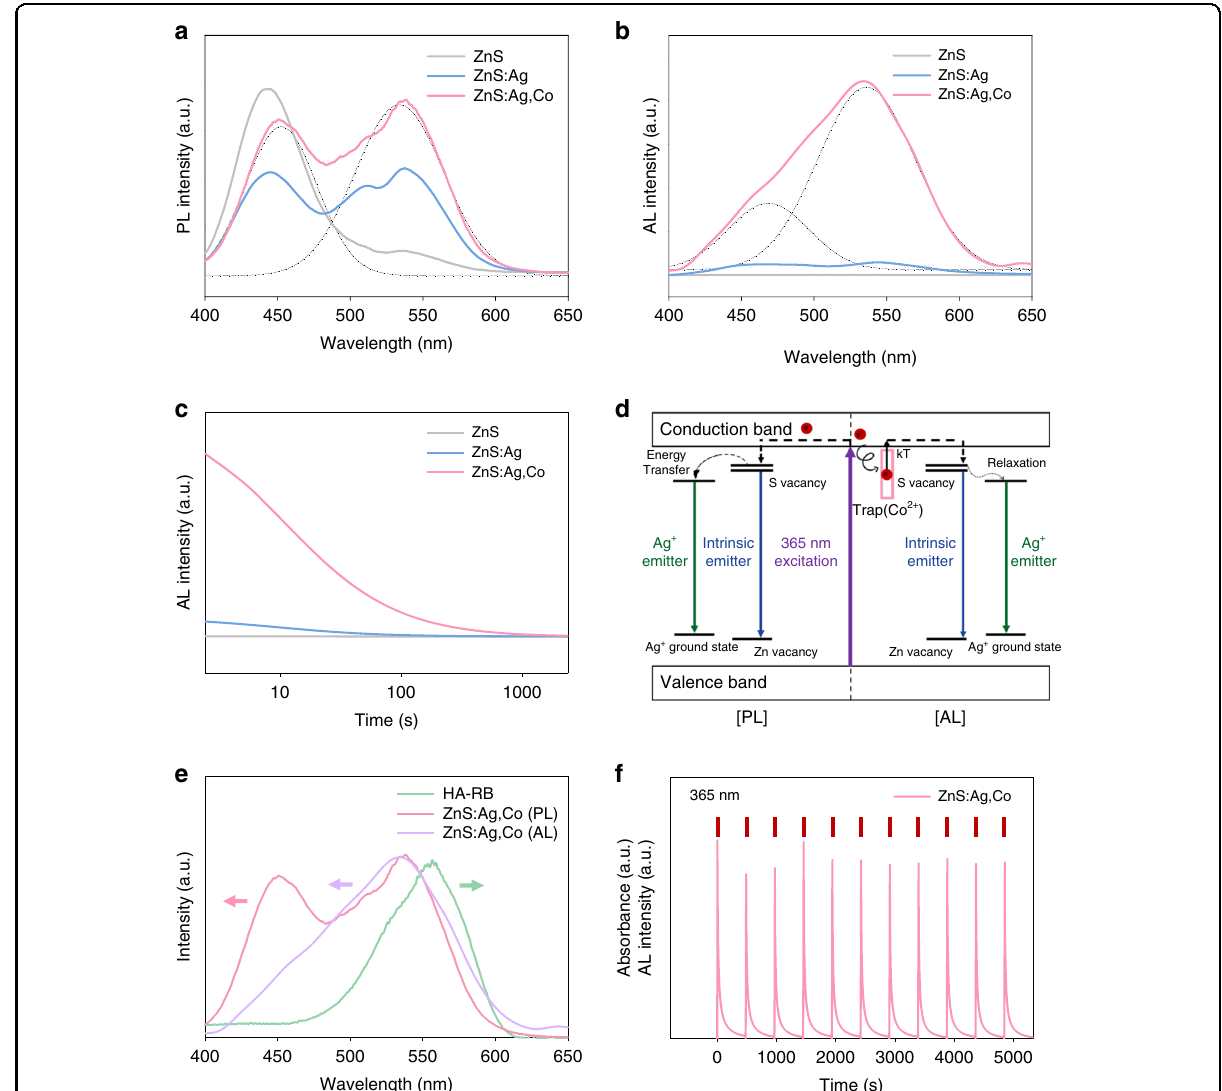
Fig. 3 The luminescence characteristics of ZnS:Ag,Co particles. a PL spectrum, b AL spectrum, and c afterglow decay curves of ZnS, ZnS:Ag, and ZnS:Ag,Co particles after UV light irradiation, respectively. d The luminescence mechanism of ZnS:Ag,Co particles. e The luminescence of ZnS:Ag,Co particles and the absorbance of HA-RB conjugates. f Time-resolved afterglow measurements of ZnS:Ag,Co particles under repetitive 365 nm recharging